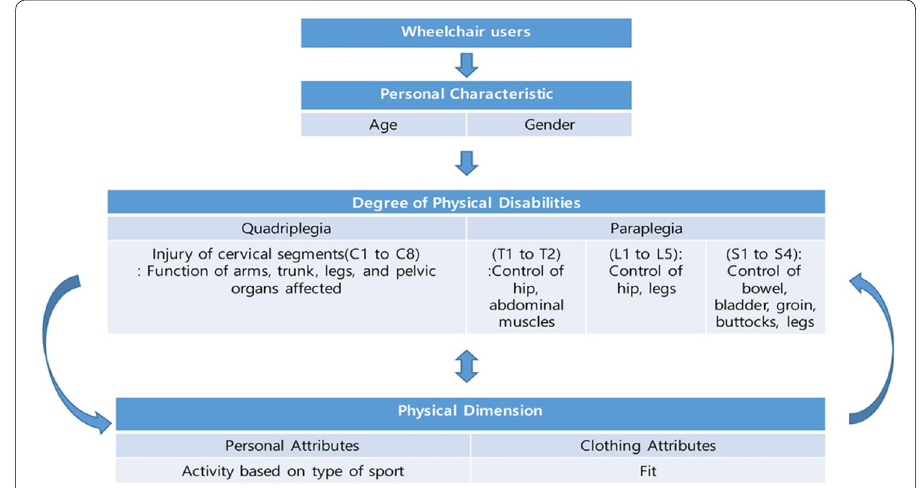
Fig. 3 The proposed model for wheelchair users’ sportswear